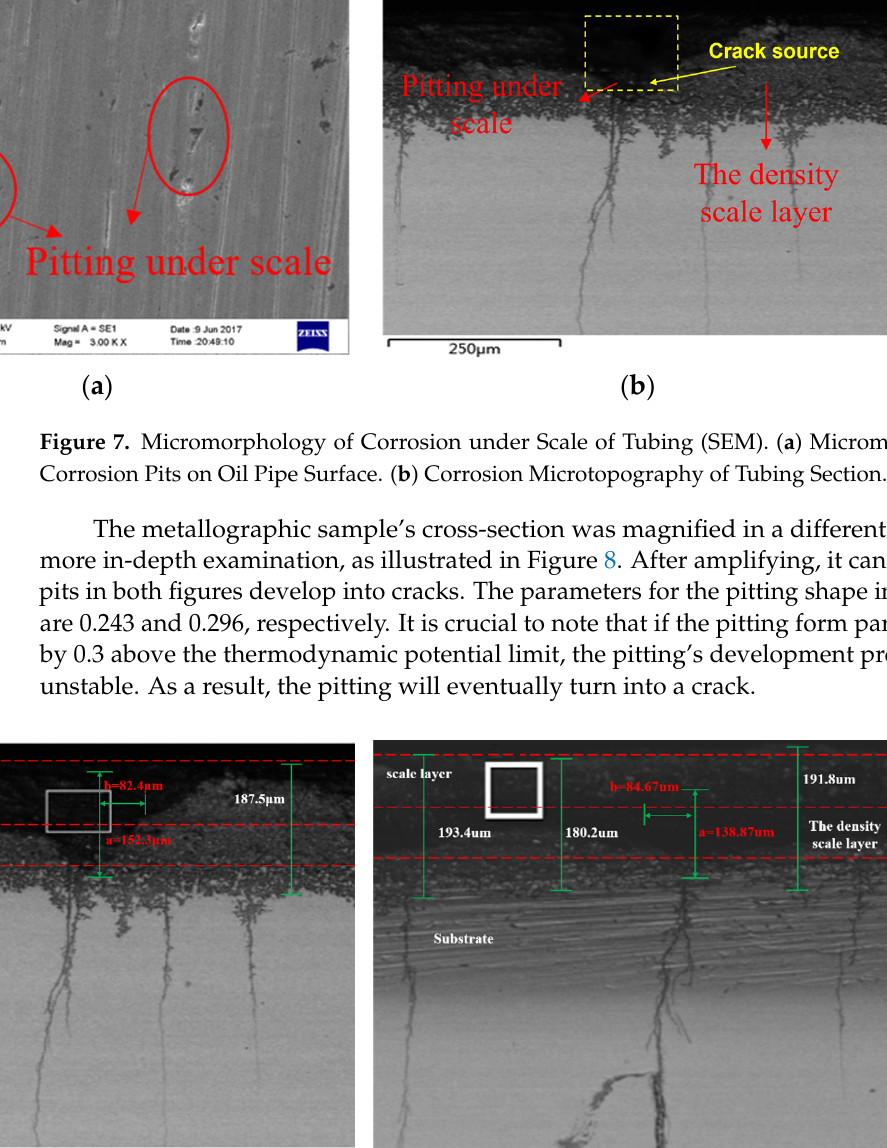
Figure 9. Section Energy Spectrum Analysis Diagram of Corrosion Scale Layer (EDS Surface Scan). Table 2. Content of O, C, Na, Mg, Al, Si, P, S, K, Ca, etc. in the Dense Scale Layer. Element